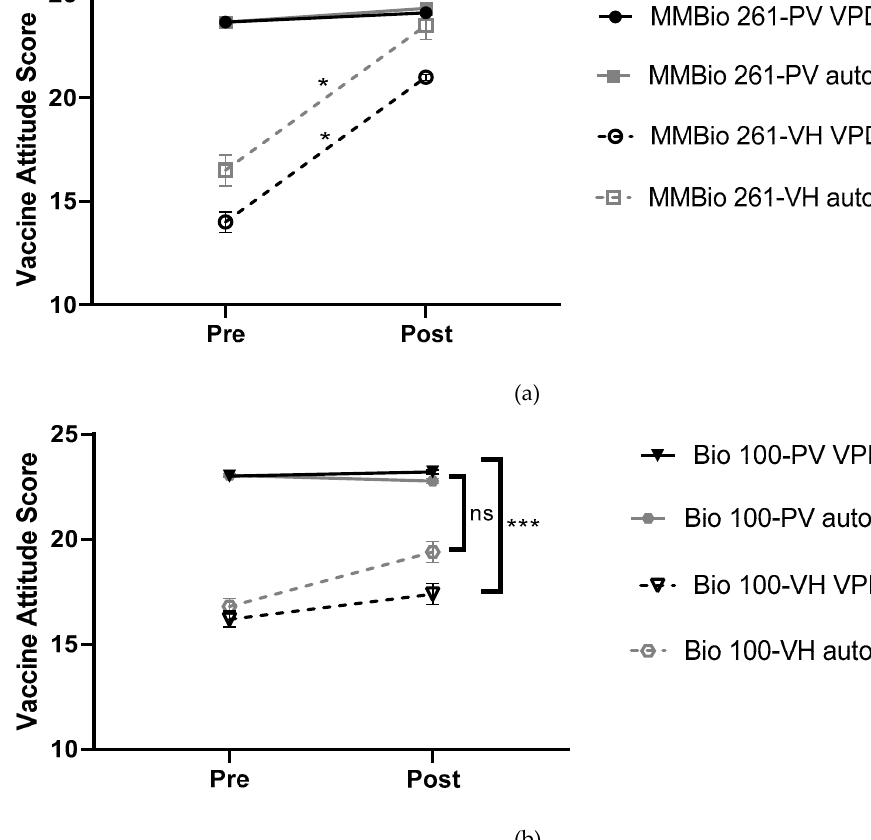
Figure 3. Education can significantly increase vaccine attitude. ( a ) Vaccine attitude scores (VASs) of MMBio 261 vaccine-hesitant students significantly increased regardless of survey intervention ( p < 0.001), Difference between pre-control group VH and pre-intervention group MMBio 261 VH students is not significant (CI diff 95% 4.72–9.71; p = 0.35). ( b ) While there is an upward VAS trend for all Bio 100 VH students, it is not significant, suggesting that education has more influence than intervention.